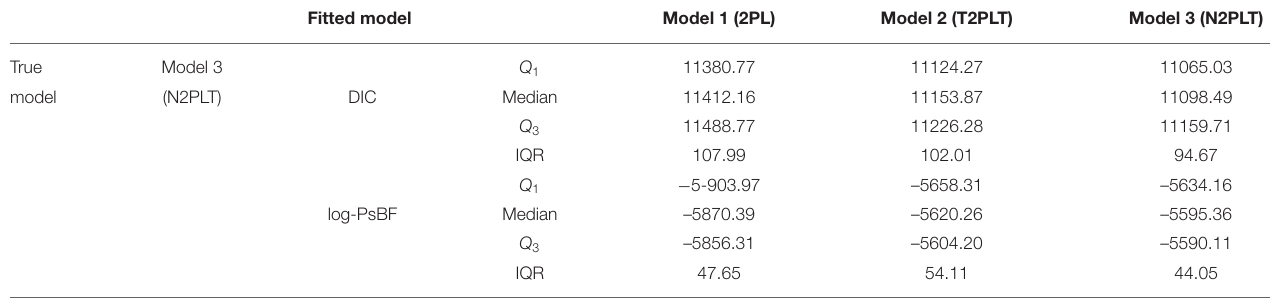
TABLE 6 | The results of Bayesian model assessment in the simulation 3.